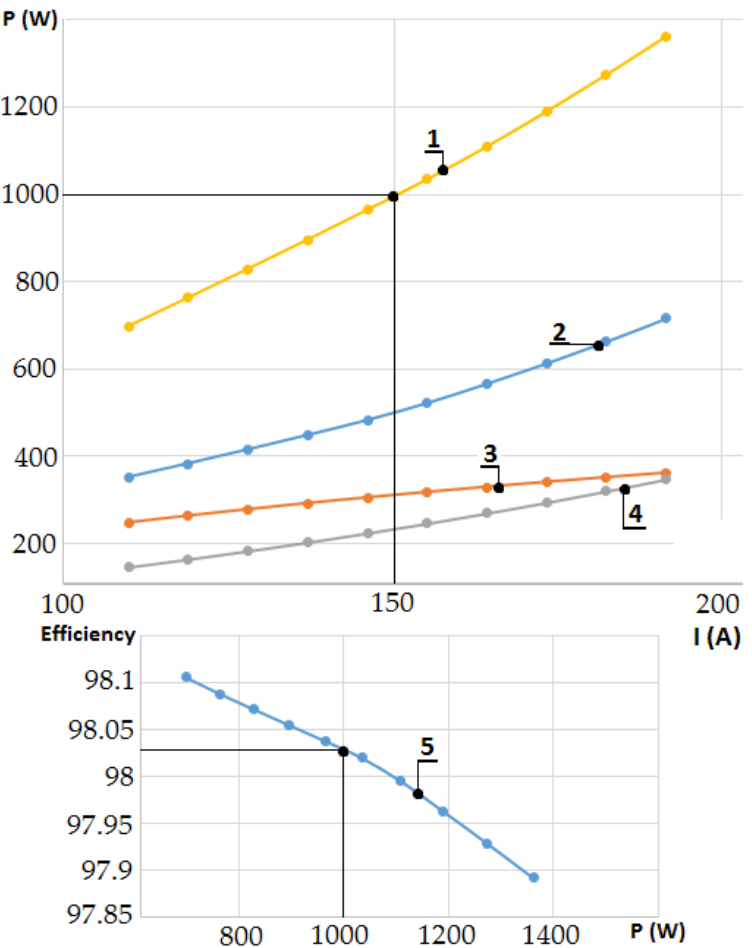
Figure 7. Buck Mode of operation. 1–DC–DC power stage losses; 2–Buck transistor Q1 losses (IGBT module M1); 3–Buck diode D1 losses (IGBT module M1); 4–Boost diode D2 losses (Boost module M2).